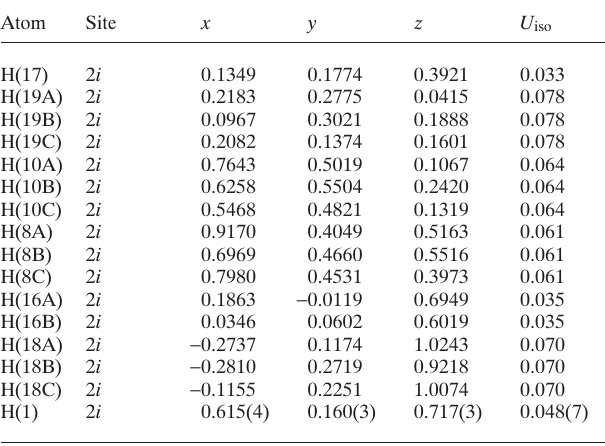
Table 2. Atomic coordinates and displace ment paramet ers (in Å 2 )